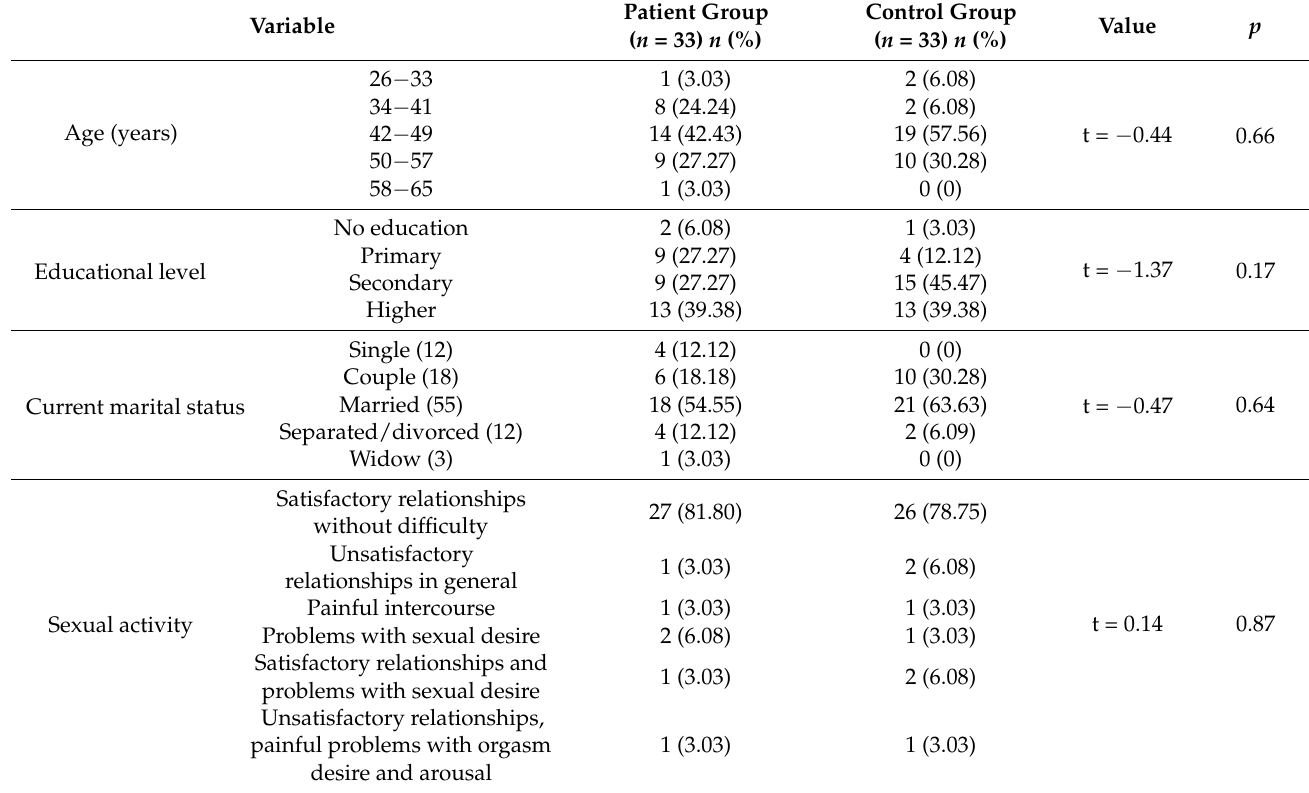
Table 1. Sociodemographic data and variables related to sexual activity in both